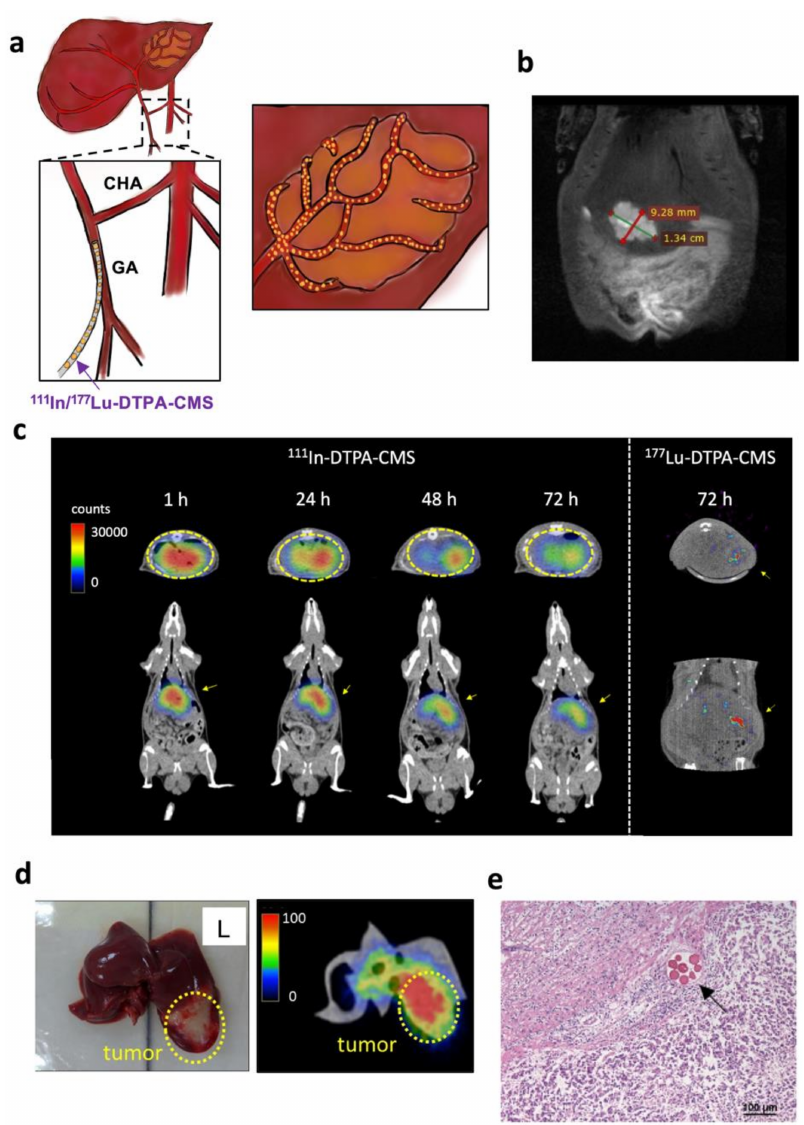
Figure 4. The distribution of 111 In-DTPA-CMS in rats with N1-S1 hepatoma. ( a ) Schematic diagram of intraarterial injection of radiolabeled chitosan microspheres. ( b ) Representative T2-weighted MR image of rats with hepatoma on day 0. ( c ) SPECT/CT images of rats intraarterially injected with 14.8 MBq of 111 In-DTPA-CMS at 1, 14, 48, and 72 h after injection ( n = 3). MicroSPECT/CT images of rats intraarterially injected with 18.5 MBq of 177 Lu-DTPA-CMS at 72 h after injection. ( d ) Ex vivo images of the liver injected with 111 In-DTPA-CMS at 72 h post-injection. ( e ) H&E staining of the liver injected with 111 In-DTPA-CMS. Microspheres were retained in the blood vessel of the tumor